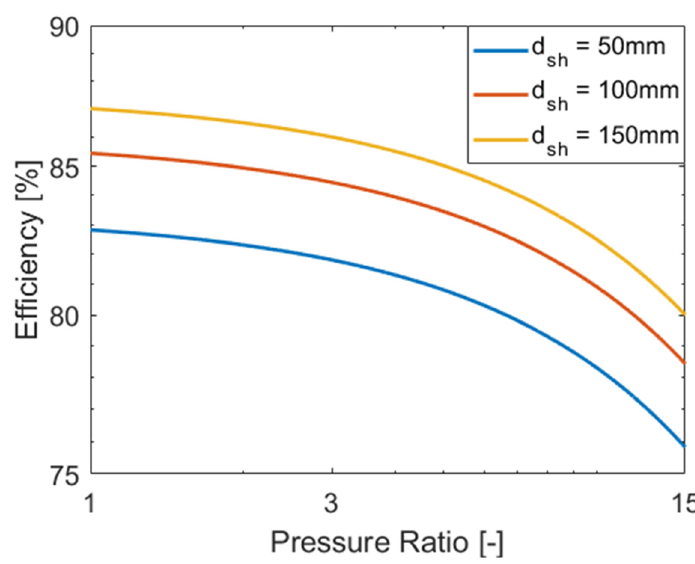
Figure 5. Turbine Polytropic Efficiency calculated using Equation (5).